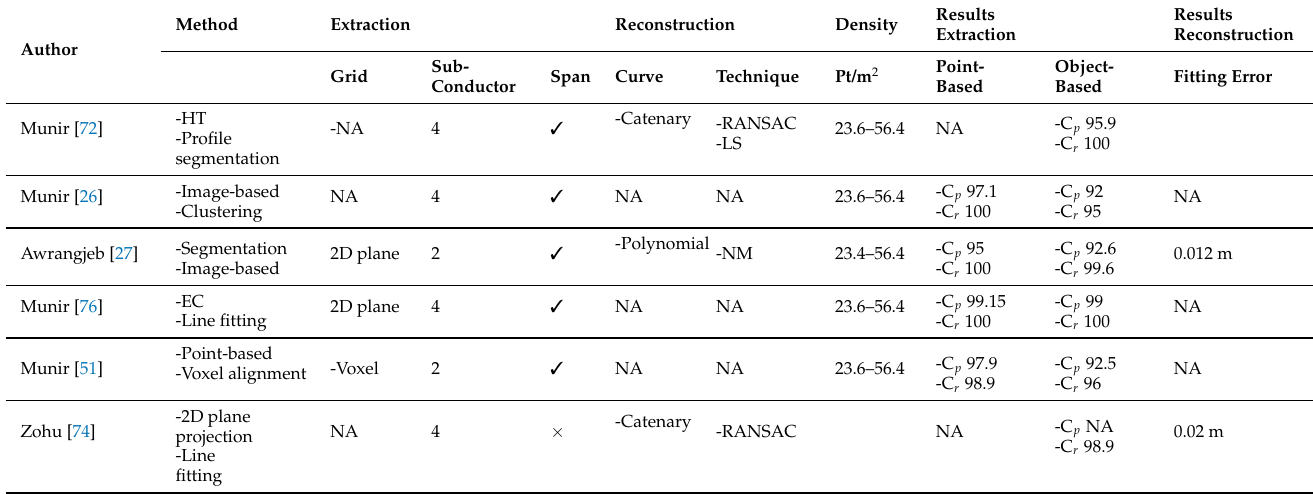
Table 4. Power line multi-conductor extraction using ALS. LS—Least square; PL—Power line; HT— Hough transform; CLF-Compass line filter; EC—Euclidean clustering; NM—Numerical method; SC Stochastic constraints; NA—Not available; C p —Completeness; C r —Correctness.